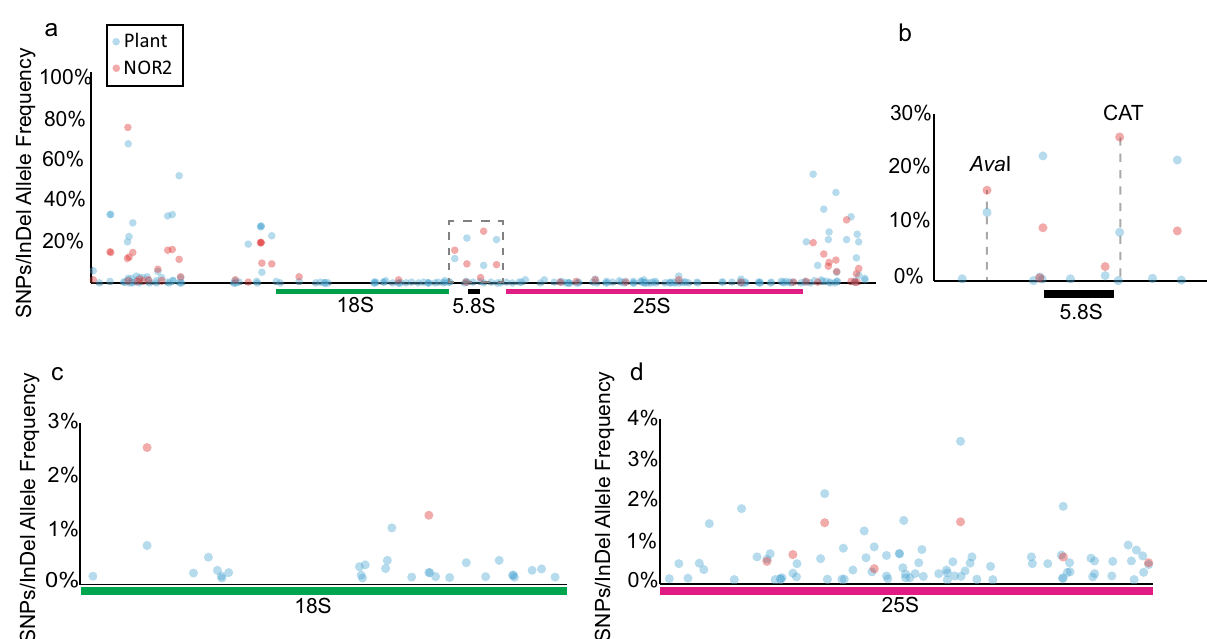
Fig. 3 rDNA variants are differentially distributed between NOR2 and NOR4. a Plot depicting the SNP/InDel allele frequencies in rDNA units derived from genomic plant DNA sequencing (blue dots; representing allele frequencies in both NOR2 and NOR4) and from BAC sequencing (red dots; representing allele frequencies only in NOR2). Dashed box indicates the enlarged area depicted in b . b 5.8S rDNA region with the AvaI and the CAT alleles highlighted. c Allele frequencies in the 18S rDNA region. d Allele frequencies in the 25 S rDNA